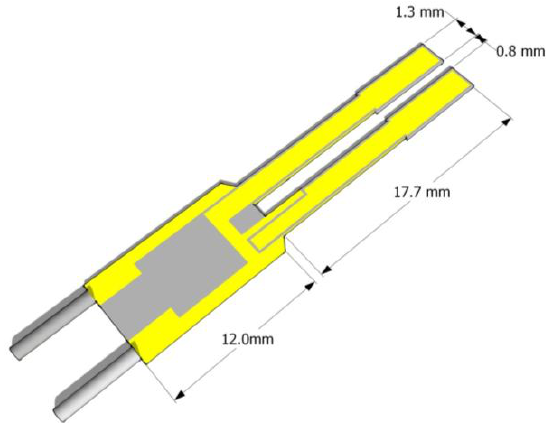
Figure 15. Schematic of a THz quartz crystal tuning-fork.